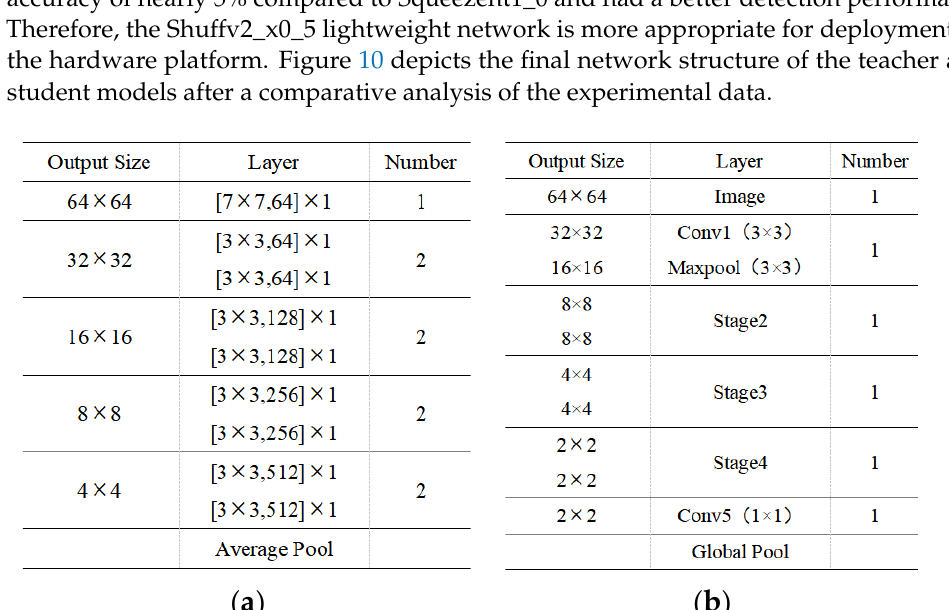
( f ) Figure 11. Comparison of the number of candidate regions produced by different threshold segmentation methods: ( a ) active image, ( b ) passive image, ( c ) Otsu-based segmentation, ( d ) candidate area segmentation based on the Otsu threshold, ( e ) proposed threshold segmentation effect, ( f ) candidate area segmentation based on the proposed threshold. The red areas in Figure 11d,f represent the candidate region detected by the Otsu and the proposed threshold segmentation methods, respectively. The experimental